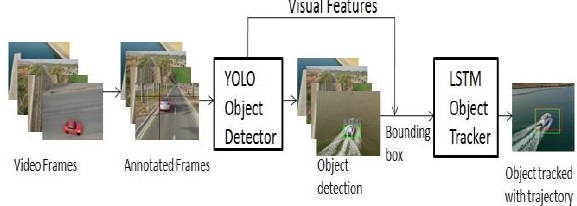
Figure 1. Architecture of single object detection and tracking